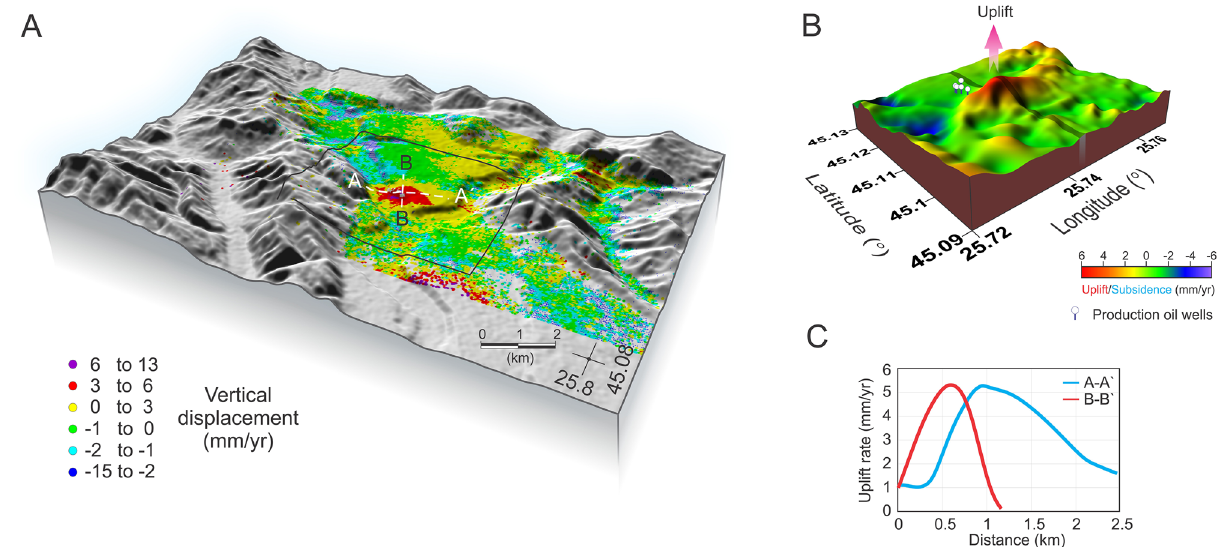
Figure 2. ( A ) InSAR uplift rates draped as data points over the gray-shaded 3-D view of the topography in the study area. The black square shows the location of the 3D view region shown in ( B ). A-A ′ and B-B ′ represent the two perpendicular cross sections through the maximum uplift region shown in ( C ). ( B ) Color-shaded 3-D view of the InSAR uplift rates. White round markers show the location of several production oilrigs. Red vertical arrow depicts the maximum uplift. The middle N–S gray band shows the location of model cut shown in Fig. 4. 3D maps in ( A,B ) are generated with the open-source software ParaView (http:// www. parav iew. org) version 5.0.1, licensed under the CC BY 4.0 license (https:// creat iveco mmons. org/ licen ses/ by/4. 0/). ( C ) Vertical cross- sections A-A ′ and B-B ′